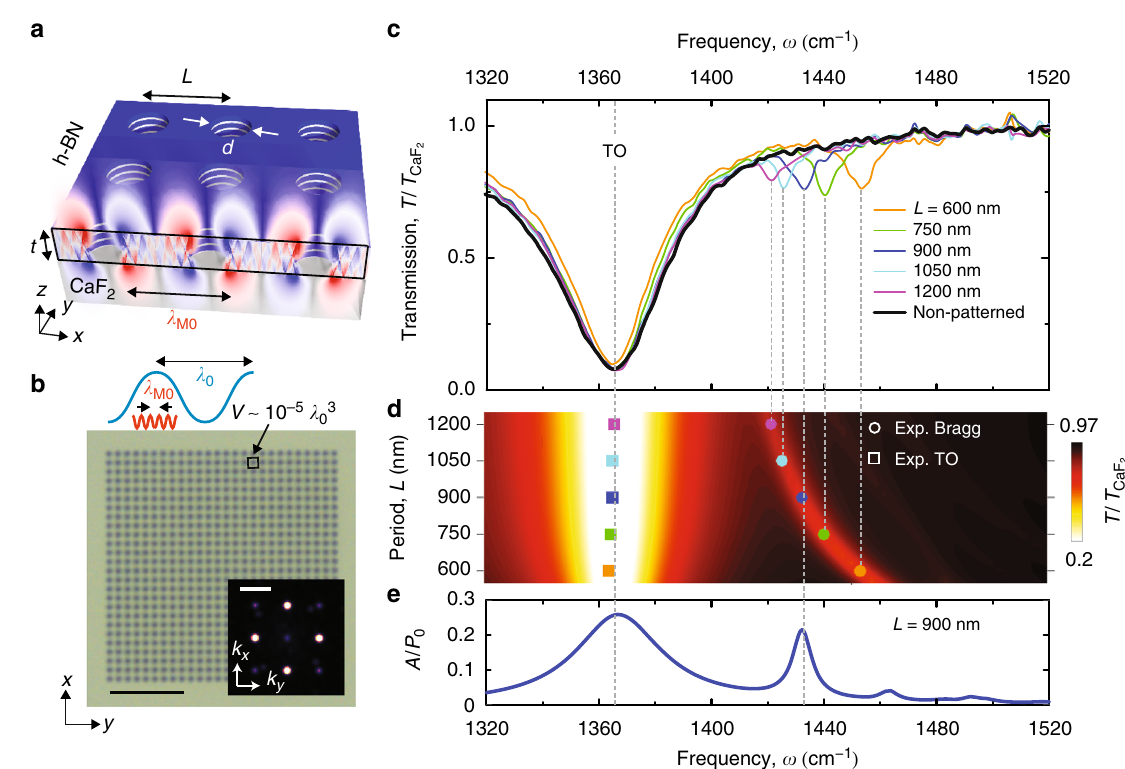
Fig. 1 Far- fi eld spectroscopy of the h-BN polaritonic crystal. a Schematics of a hole array in a h-BN slab with thickness t = 38 nm on a CaF 2 substrate. b Optical image of a hole array with period L = 600 nm. The blue and red oscillations represent the wavelength of light in free space, λ 0 , and that of the M0 mode, λ M0 , respectively. The inset shows the Fourier transform of the optical image. c Experimental normalized transmission spectra for the hole arrays with L ranging from 600 to 1200 nm. d Simulated transmission as a function of frequency and L (colormap). The points indicate the position of the dips from the experimental spectra. e Simulated absorption spectra of the hole array with L = 900 nm. Scale bar in ( b ): 5 μ m. Scale bar in the inset of ( b ): 2 π /600 nm −